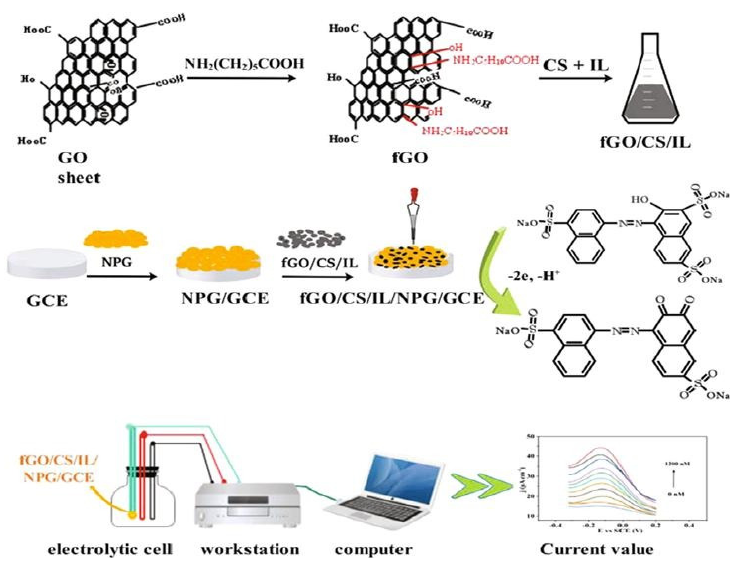
Figure 6. Schematic analysis of novel electrochemical sensor prepared by fGO/chitosan/ionic liquid nanocomposite [120].